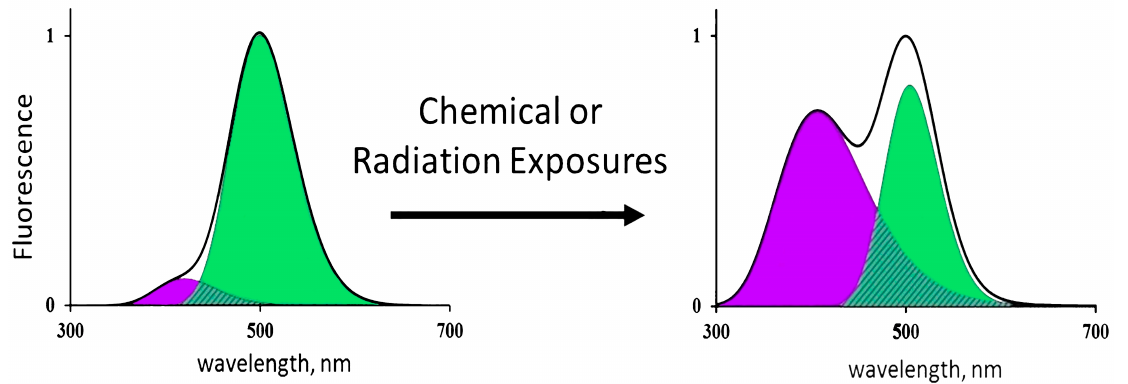
Figure 3. Change of the fluorescence spectra of CLM-containing fluorescence proteins exposed to chemical agents or radiation.